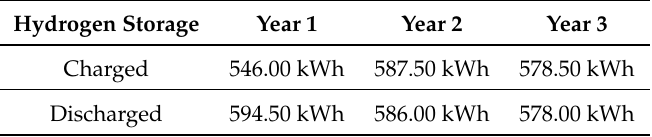
Figure 5. Hydrogen state of charge (SoC) percentage over three years. Table 4. Hydrogen storage SoC